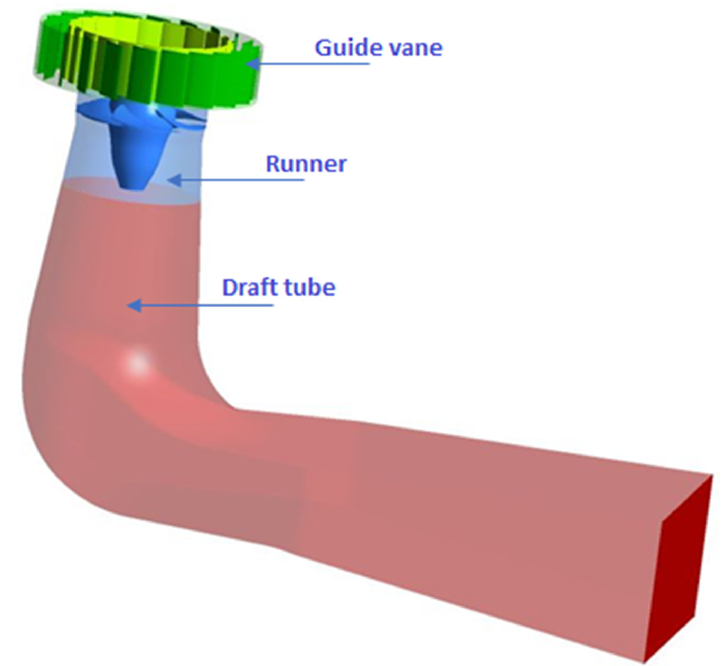
Figure 1. Computational domains.